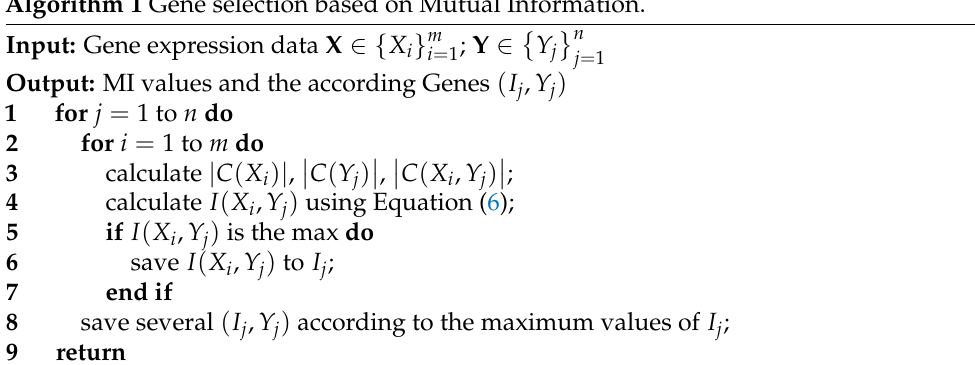
Algorithm 1 Gene selection based on Mutual